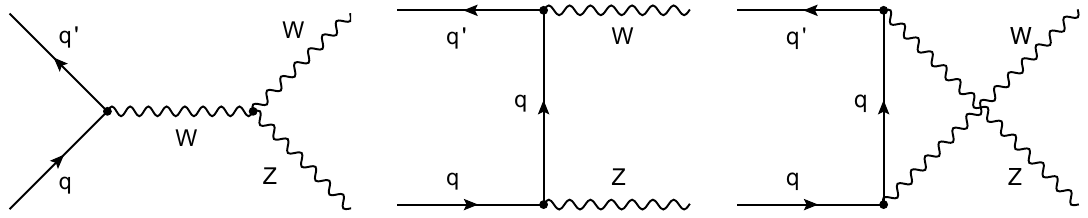
Figure 1 . Feynman diagrams for resonant WZ production at leading order in proton-proton collisions. The contributions from the s channel (left), t channel (middle), and u channel (right) are shown. The contribution from the s channel proceeds through a